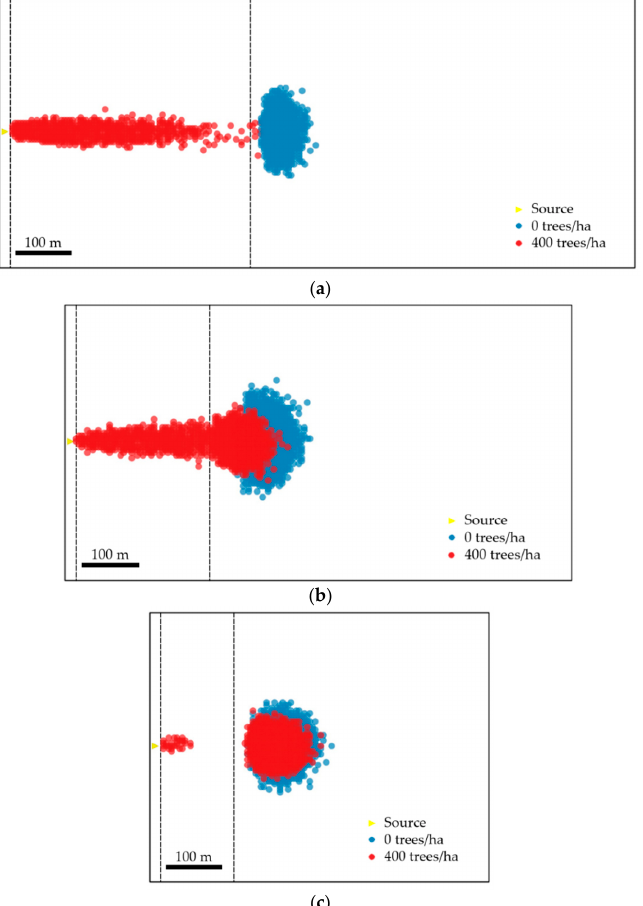
Figure 7. Maps of deposited blocks in the case of a spherical block with a unitary volume. Upper and lower limits of the transit zone (zone 2) are indicated in black dashed lines. The blue area refers to the scenario with 0 trees/ha, while the red one refers to the scenario with 400 trees/ha. Slope inclination 𝜔 (cid:2870) : ( a ) 30°, ( b ) 45° and ( c ) 60°.